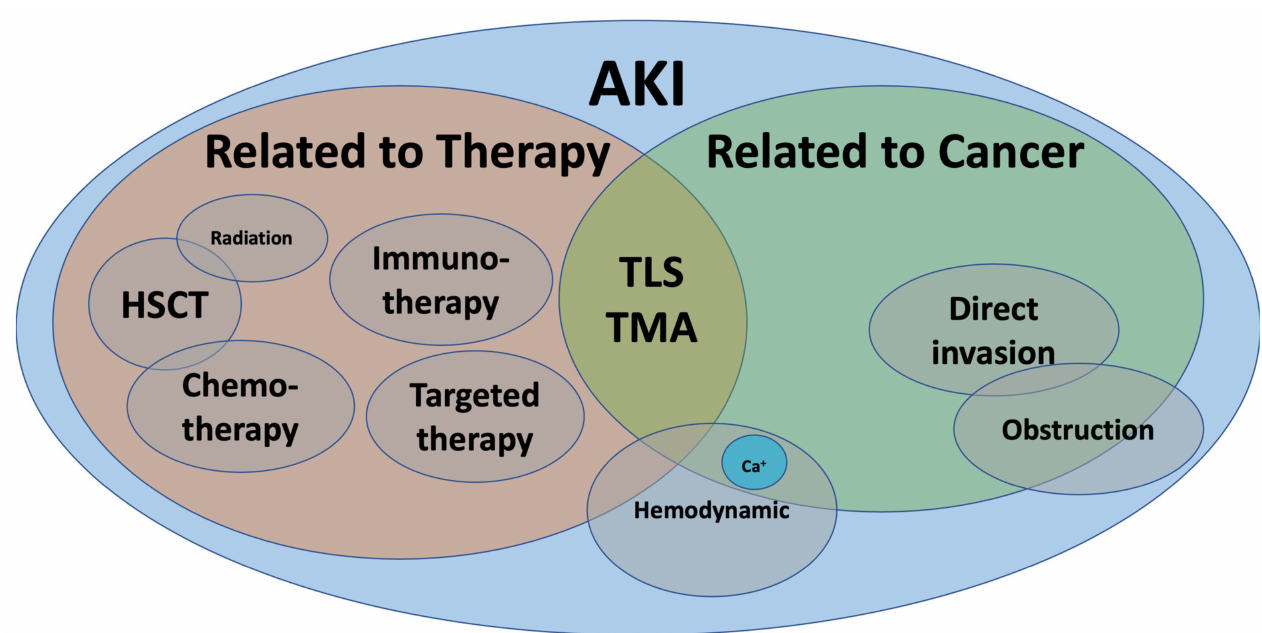
Figure 1. Acute kidney injury in cancer.AKI: acute kidney injury, Ca +: calcium, HSCT: hematopoietic stem cell transplant, TLS: tumor lysis syndrome, TMA: thrombotic